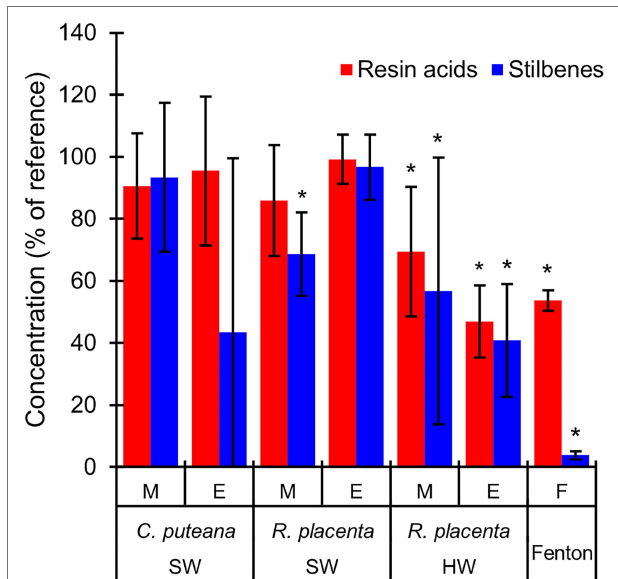
FIGURE 6 | Average concentrations (as % of reference) of the original stilbenes and resin acids in the heartwood extract after incubation with mycelium (M) or extracellular culture fluid (E) from C. puteana and R. placenta cultures supplemented with sapwood (SW) or heartwood (HW) powder, or with Fenton reagent. Coniophora puteana did not grow in heartwood- supplemented culture. Error bars represent ±SD. *Statistically significant difference to reference ( p < 0.05 according to Student’s t -test). N = 5.